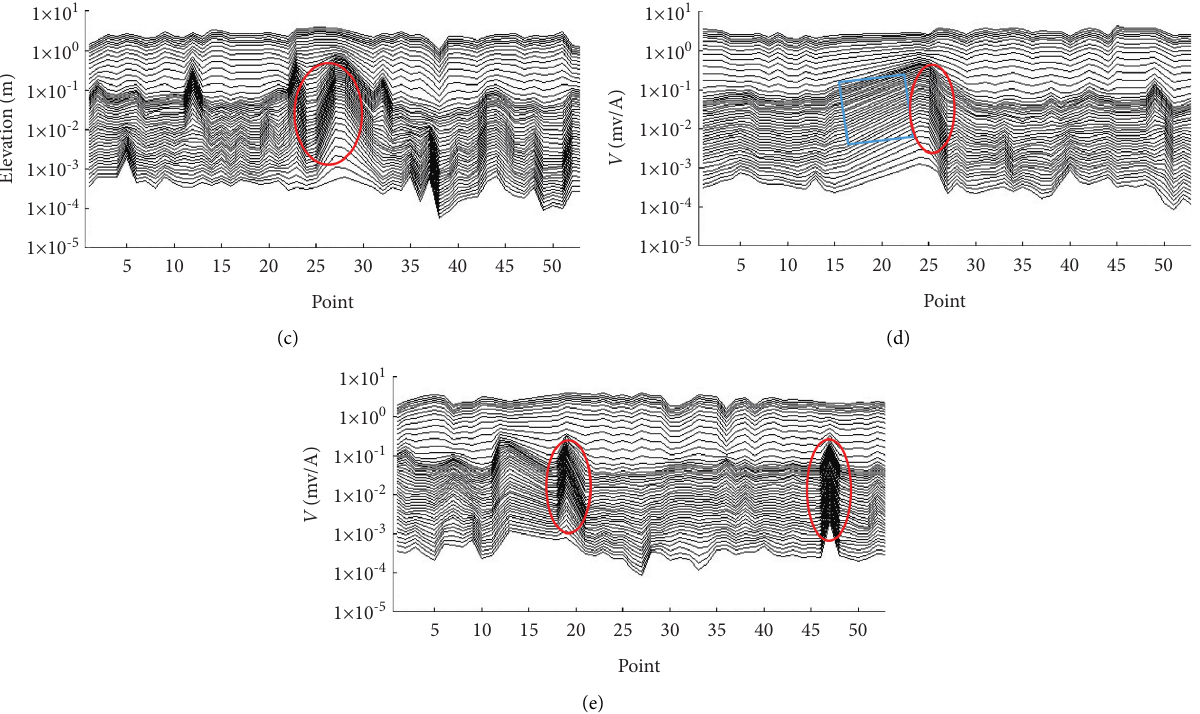
Figure 13: Multichannel voltage profile of each line. (a) Line 5, (b) line 6, (c) line 9, (d) line 13, and (e) line 20.